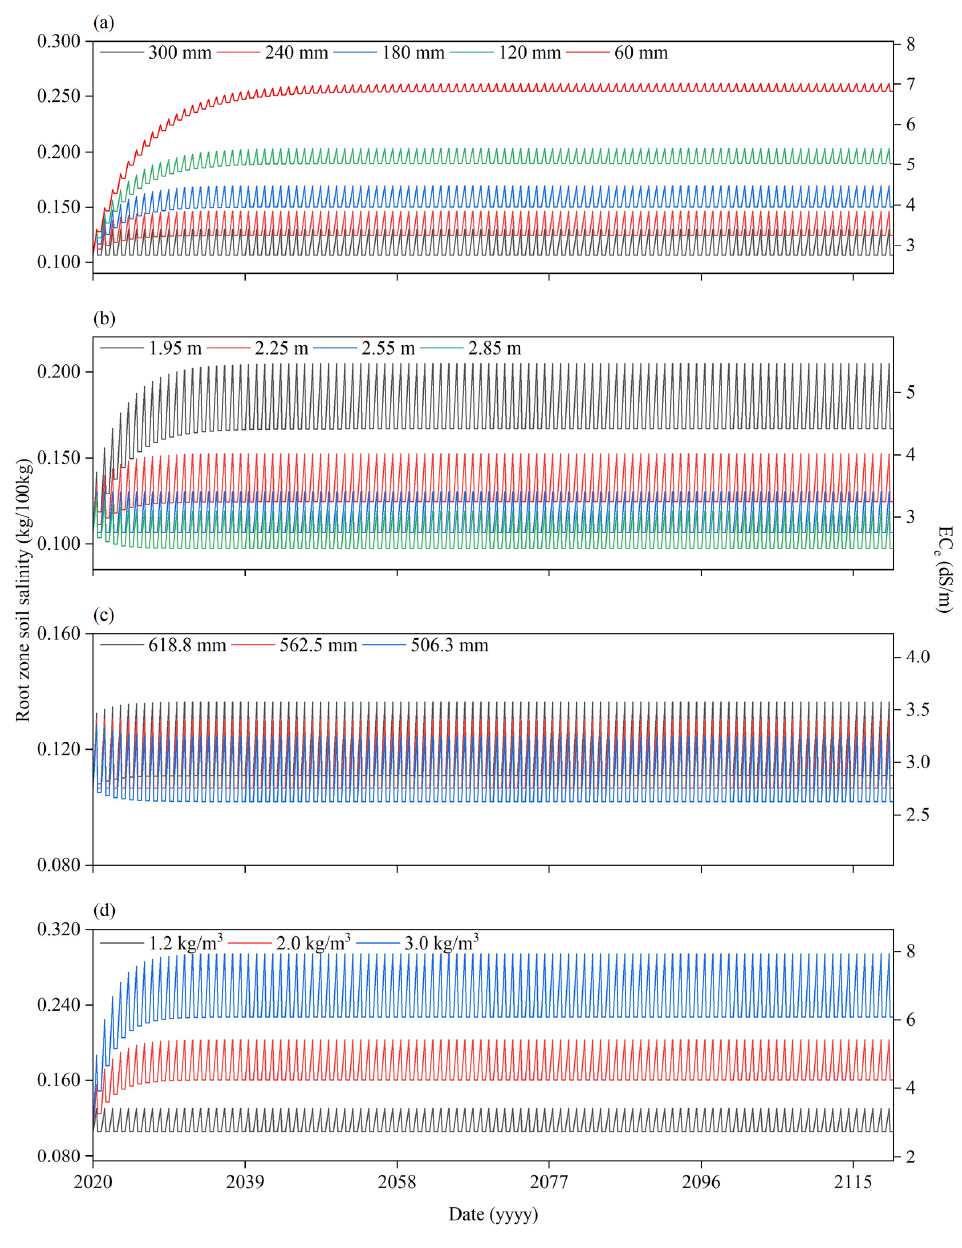
Figure 11. Root zone soil salinity variation in the well-irrigated area under different ( a ) autumn irrigation, ( b ) water table depth, ( c ) irrigation in the crop growing period, ( d ) groundwater salinity.